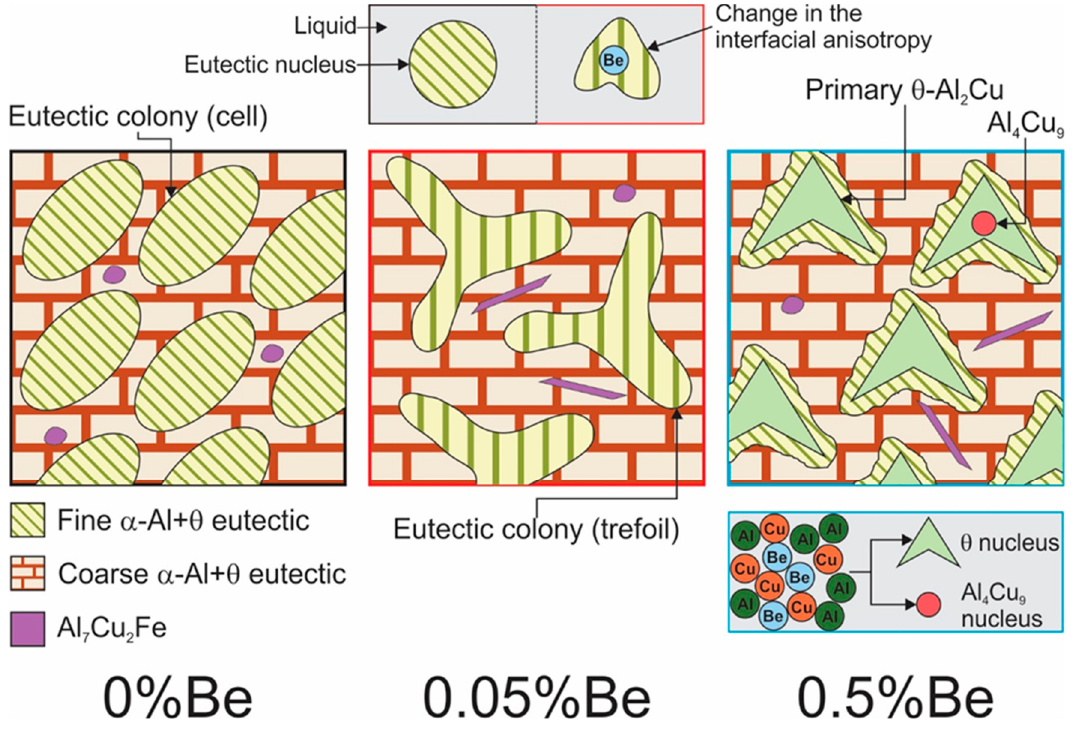
Figure 13. Schematic representation of the mechanism proposed to explain the microstructural changes promoted by beryllium in the Al-33 wt.%Cu alloy.